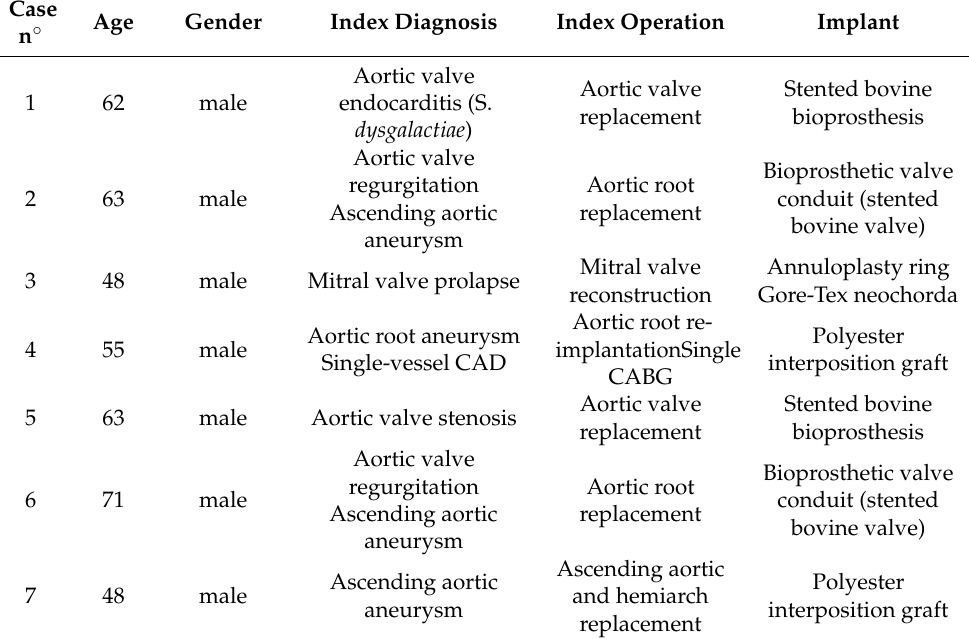
Table 1. Patients’ characteristics at the index